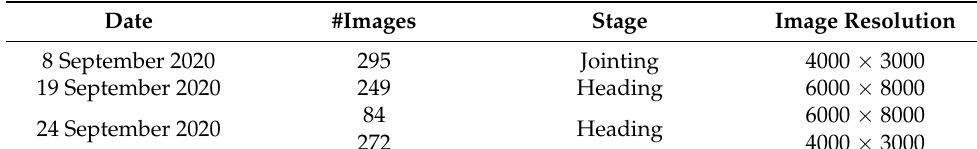
Table 2. Date and quantity of data collection.